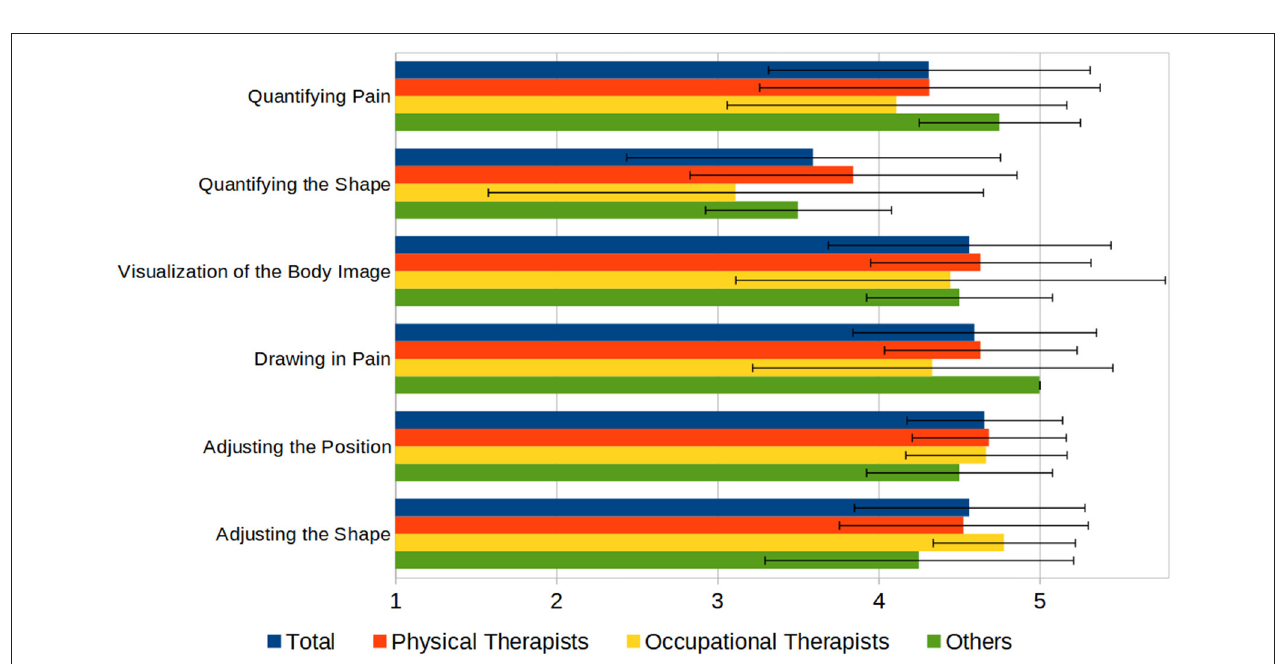
differentiated adjustment, especially of the fingers and